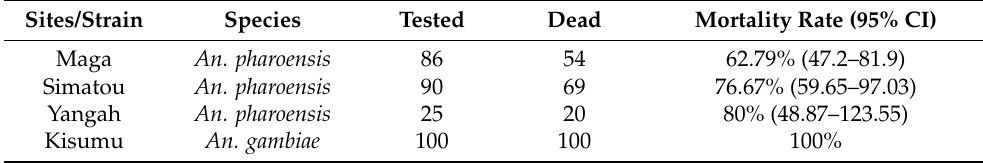
Table 2. Susceptibility status of An. pharoensis populations to 4% DDT.